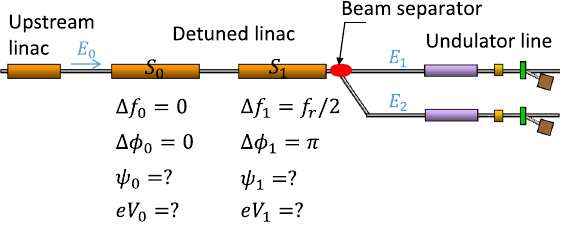
FIG. 4. Layout of the SRF linac to support three undulator lines with off-frequency detune